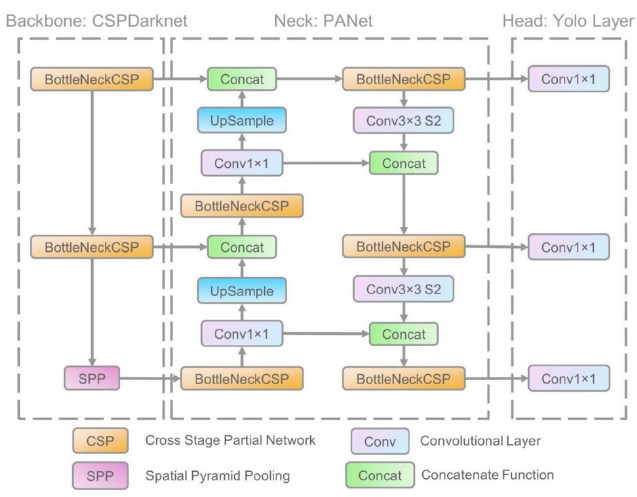
Figure 8. Architecture of